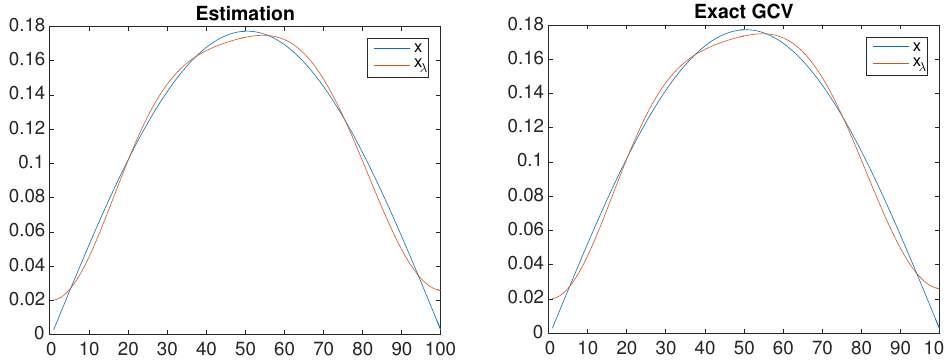
Figure 2. Solution of the Tomo test problem via an estimation of GCV ( left ) and the exact GCV ( right ).